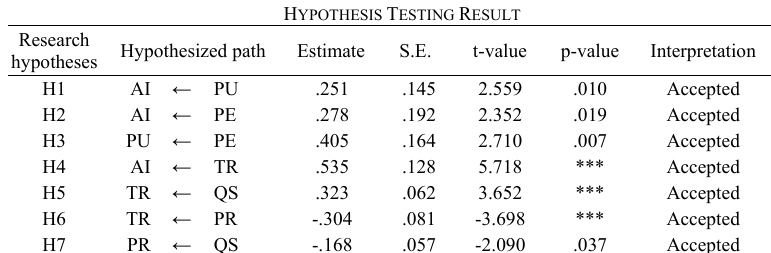
TABLE 7 H YPOTHESIS T ESTING R